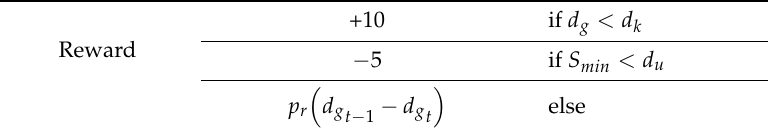
Table 3. Reward Table 3. Reward shaping.